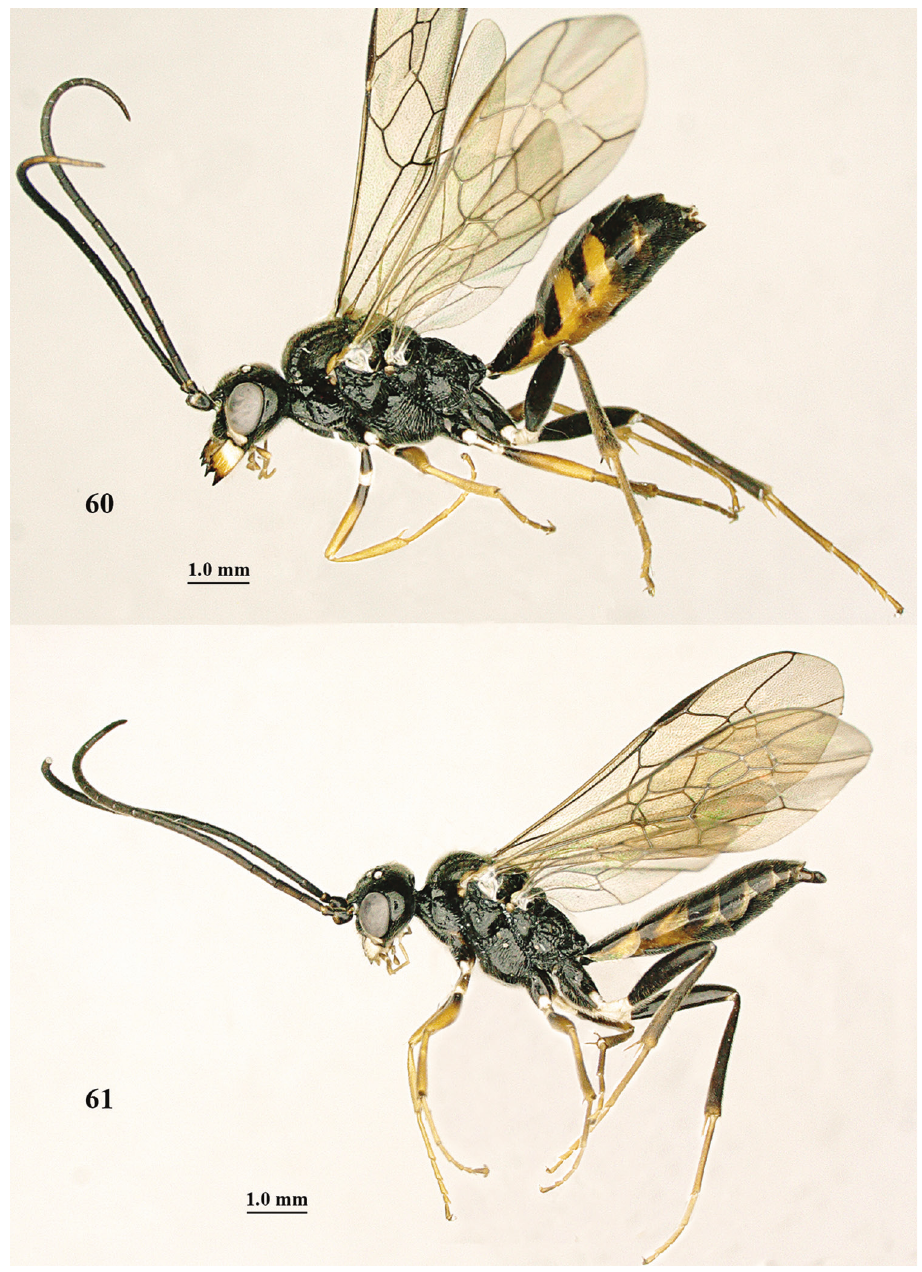
Figures 60, 61. Orthogonalys paraclypeata Tan & van Achterberg, sp. n. 60 female, holotype, habitus lateral 61 male, paratype, habitus